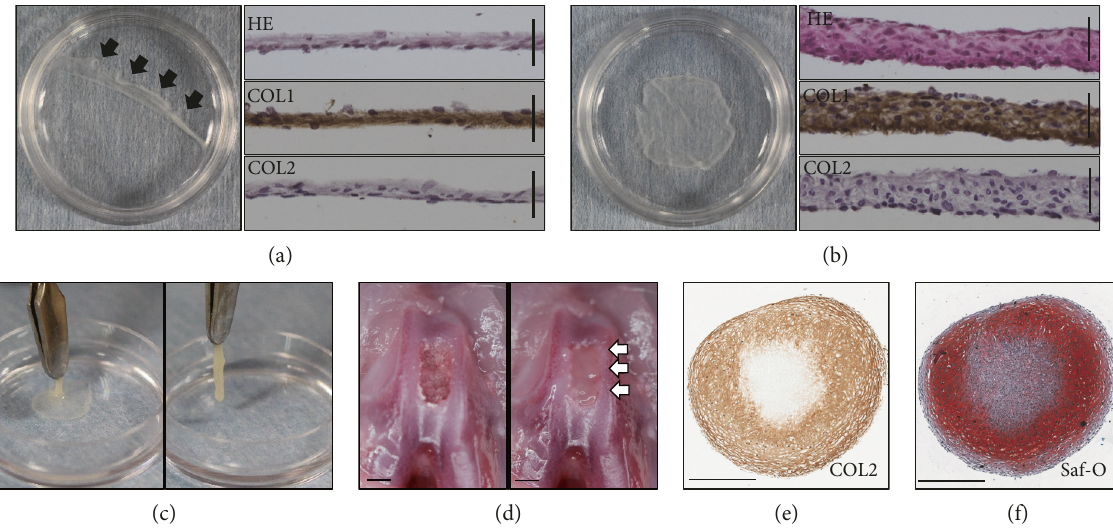
Figure 6: In vitro development of tissue-engineered tissue from iNCMSCs. (a – c) The gross appearance of iNCMSC-TEC developed in 35 mm dishes at day 7. Thin monolayer cell sheet was formed in the culture bottom surface after 7 days of high-density culture (a), and once arti fi cially detached (black arrows), a thick sheet-like construct (iNCMSC-TEC) developed through active tissue contraction within a few minutes (b). HE staining and immunostaining for COL1 and COL2 of transverse section are shown in their corresponding right panels. Scale bars =50 μ m. The iNCMSC-TEC exhibited su ffi cient strength to handle with forceps (c). (d) Ex vivo implantation of iNCMSC-TEC into osteochondral defects of cadaver rats. iNCMSC-TEC readily fi lled the defect created in the femoral groove (white arrows). Scale bars =1mm. (e, f) Chondrogenic potential of iNCMSC-TEC. COL2 immunostaining (e) and Safranin-O staining (f) of iNCMSC-TEC cultured in chondrogenic medium for 1 month. Scale bars =500 μ m. Abbreviations: HE: hematoxylin and eosin staining; COL1: type 1 collagen; COL2: type 2 collagen; Saf-O: